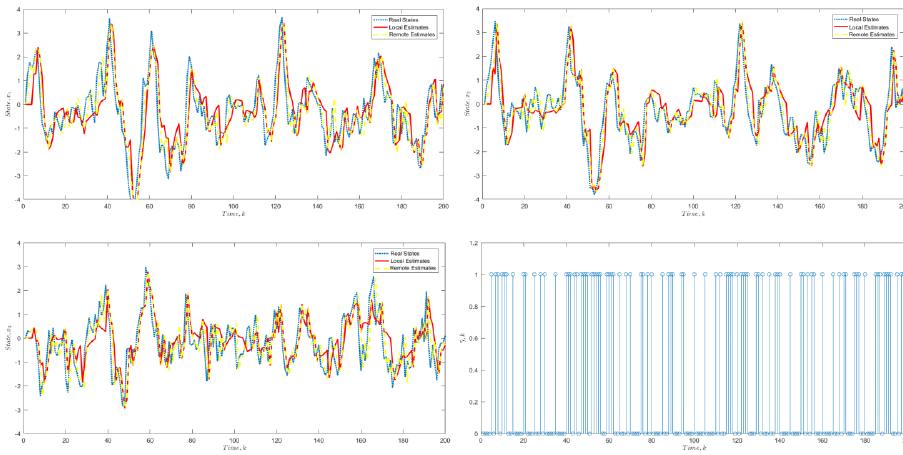
Figure 2. Estimation performance of state with Σ − 1